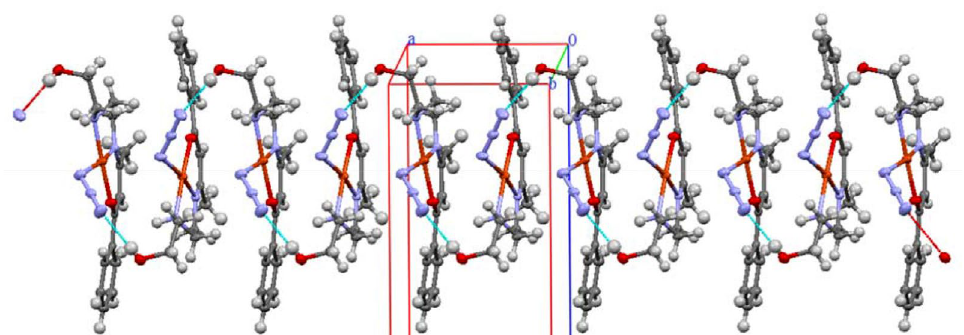
Fig. 3. The intermolecular hydrogen bonding between uncoordinated hydroxyl group of ligand and terminal nitrogen atom of neighboring coordi- nated azide ligand in complex 1 along a axis.